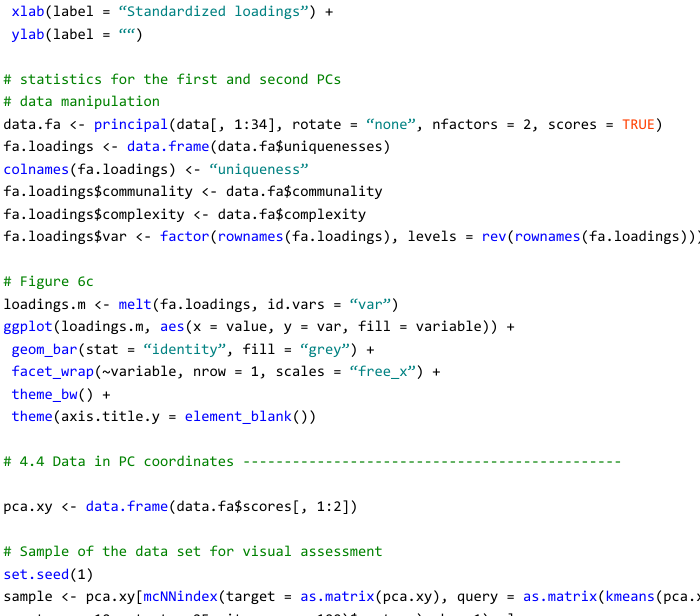
# Figure 8a fviz_nbclust(scale(data[, 1:34]), FUNcluster = clara, diss = dist(scale(data[, 1:34]), method = “manhattan”), method = “gap_stat”) # 5.2 Data clustering